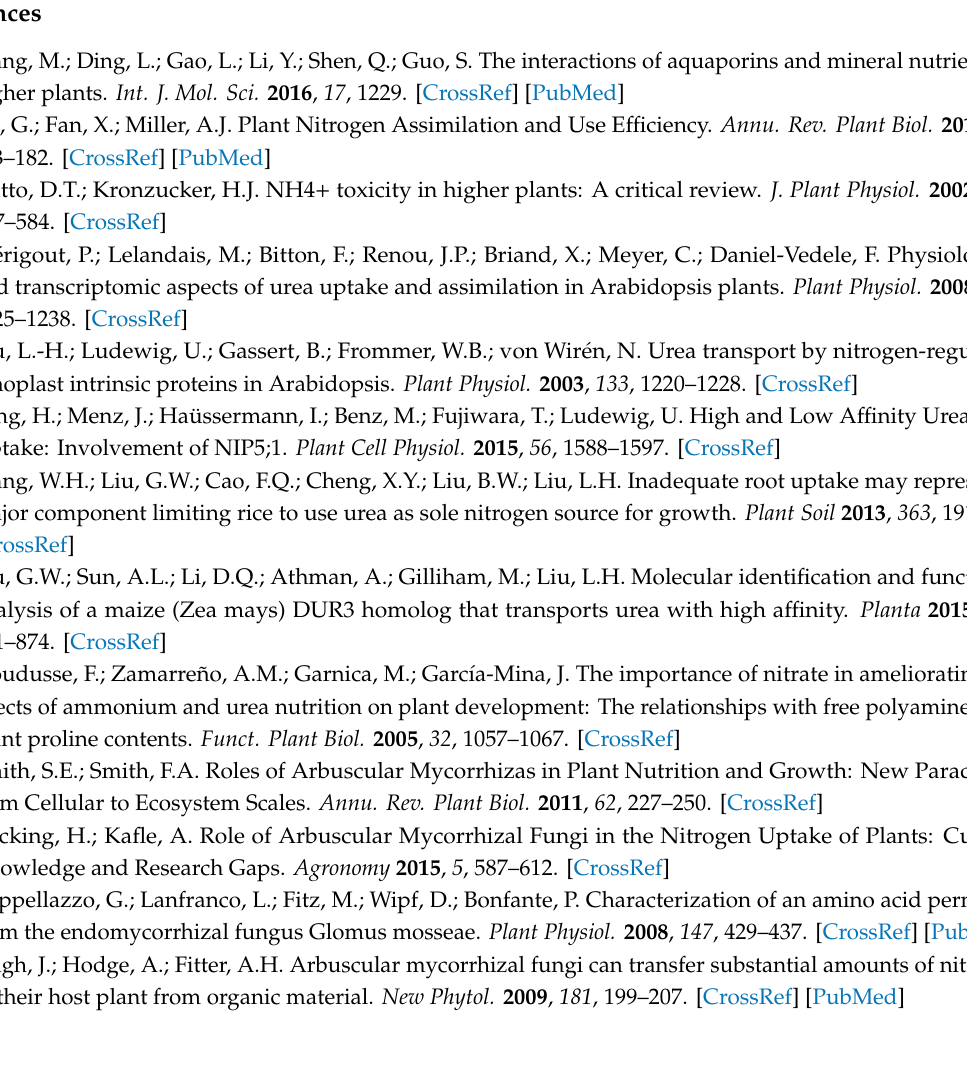
Table S1: one-way ANOVA for data presented in this study. Table S2: multifactorial ANOVA for data presented in this